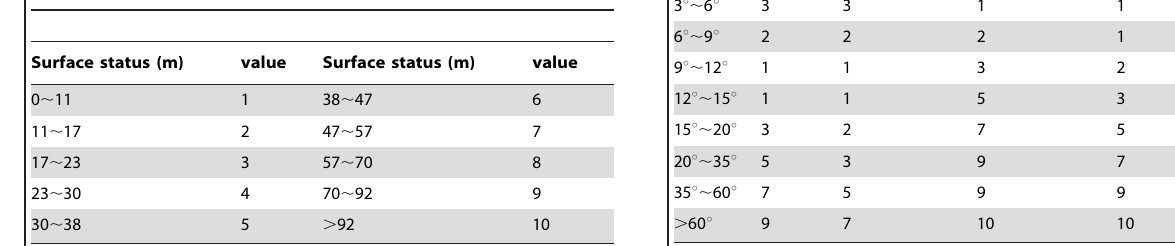
Table 3. The quantified result in accordance with the surface status.